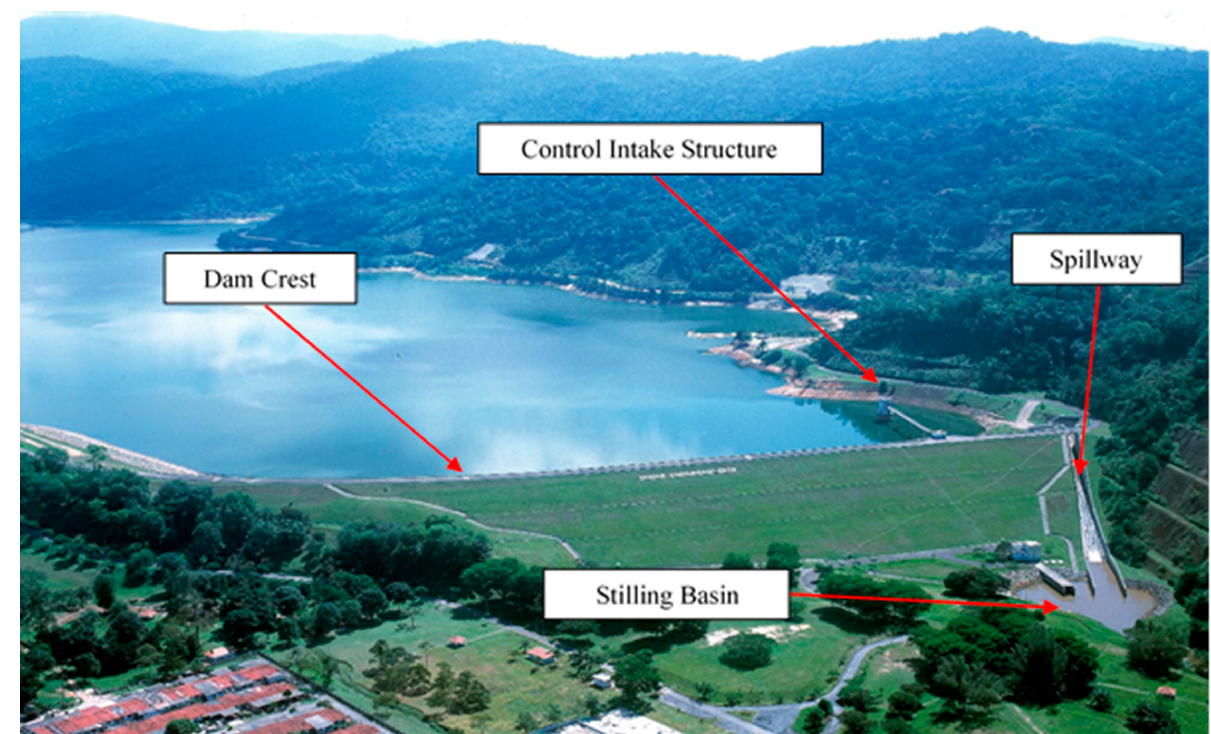
Figure 2. Components of Batu Dam.